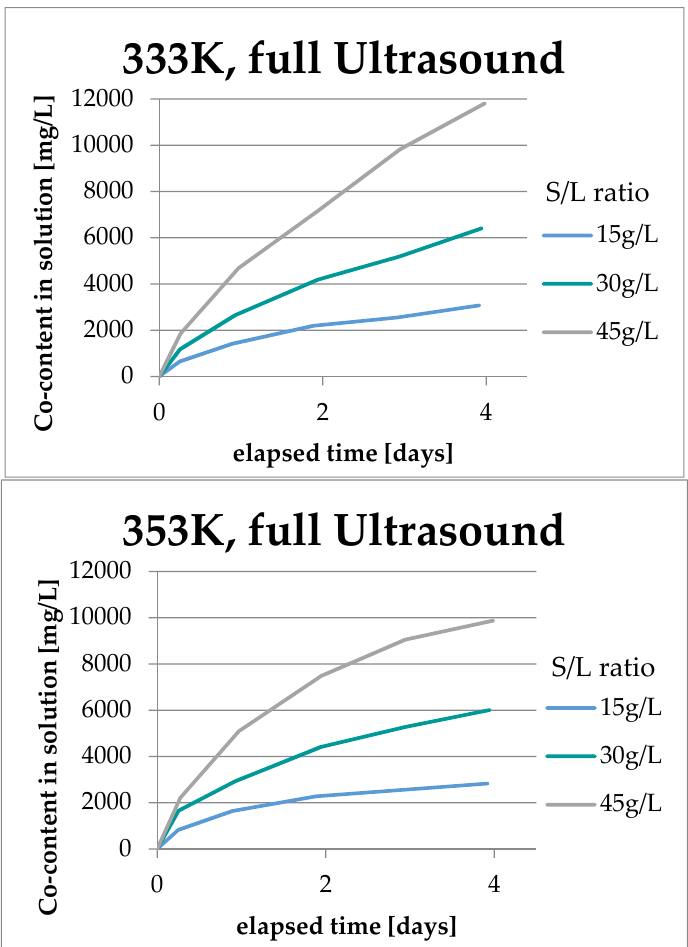
Figure 8. Concentration of cobalt in solution in time between 333 K and 353 K with full-time ultrasound.